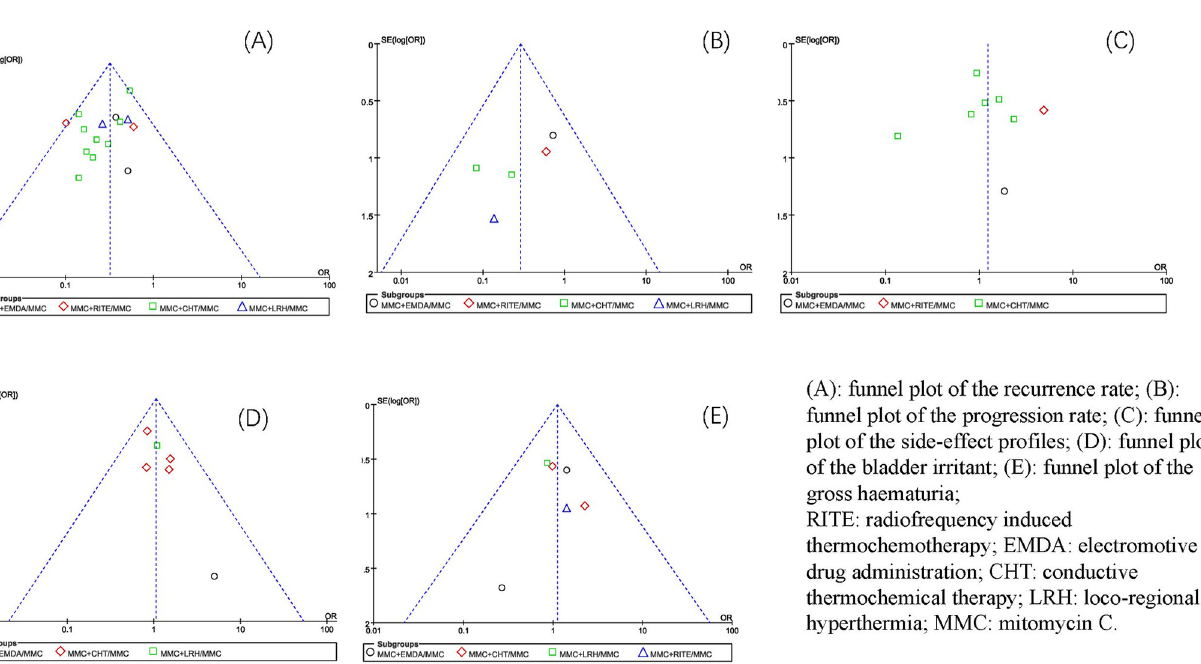
PLOS ONE | https://doi.org/10.1371/journal.pone.0276453 October 21,